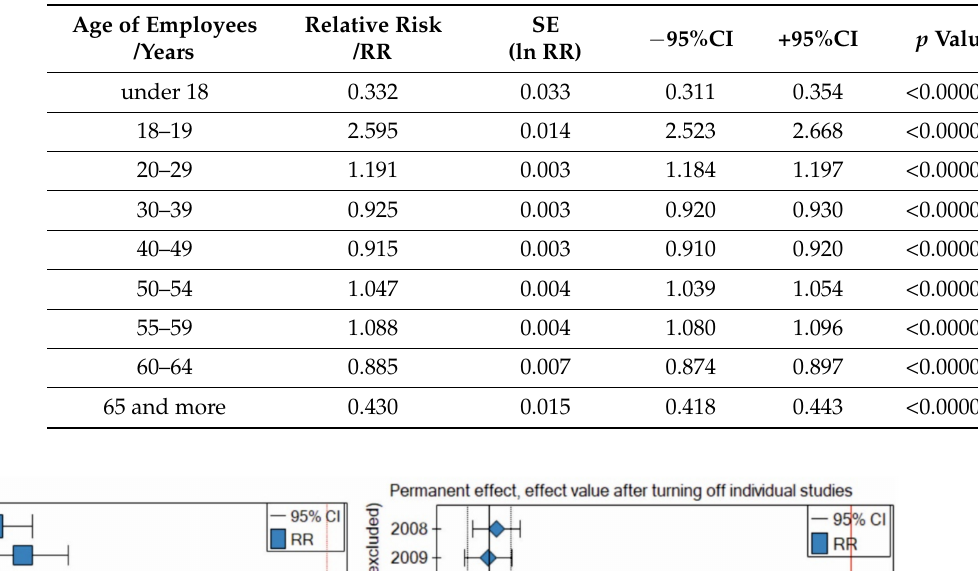
Table 3. Summary of the meta-analysis for all age groups (own elaboration).